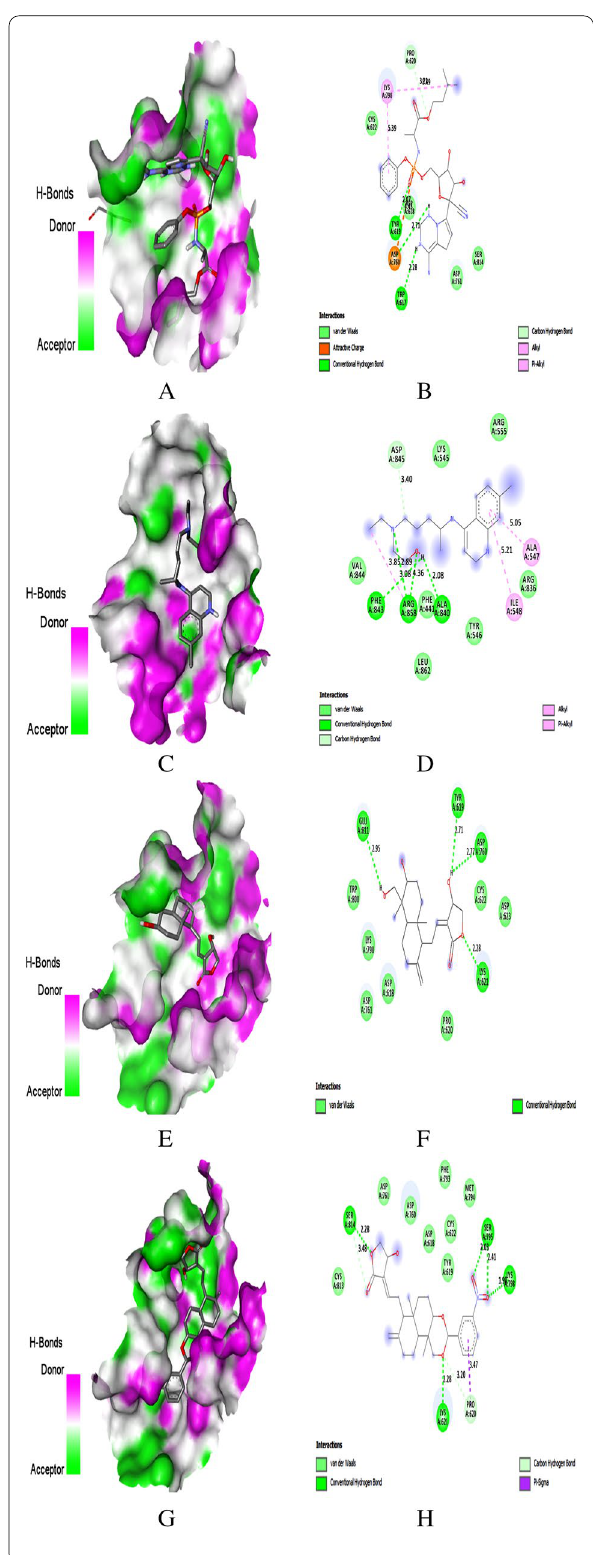
Fig. 5 Docking with RdRp. A Docking pose of REM on hydrogen bonding surface. B ) 2D interaction of REM. C Docking pose of HCQ on hydrogen bonding surface. D 2D interaction of HCQ. E Docking pose of AGP on hydrogen bonding surface. F 2D interaction of AGP. G Docking pose of AGP-14 on hydrogen bonding surface H 2D interaction of